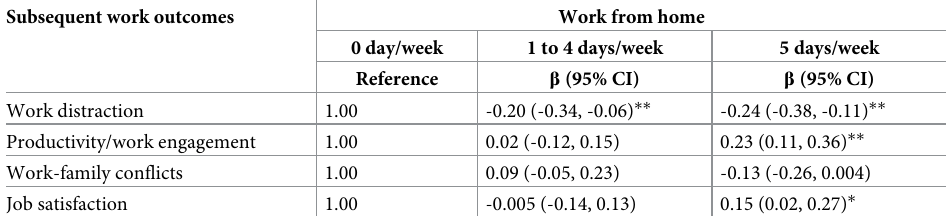
Table 2. The associations between work from home and subsequent work outcomes (N =